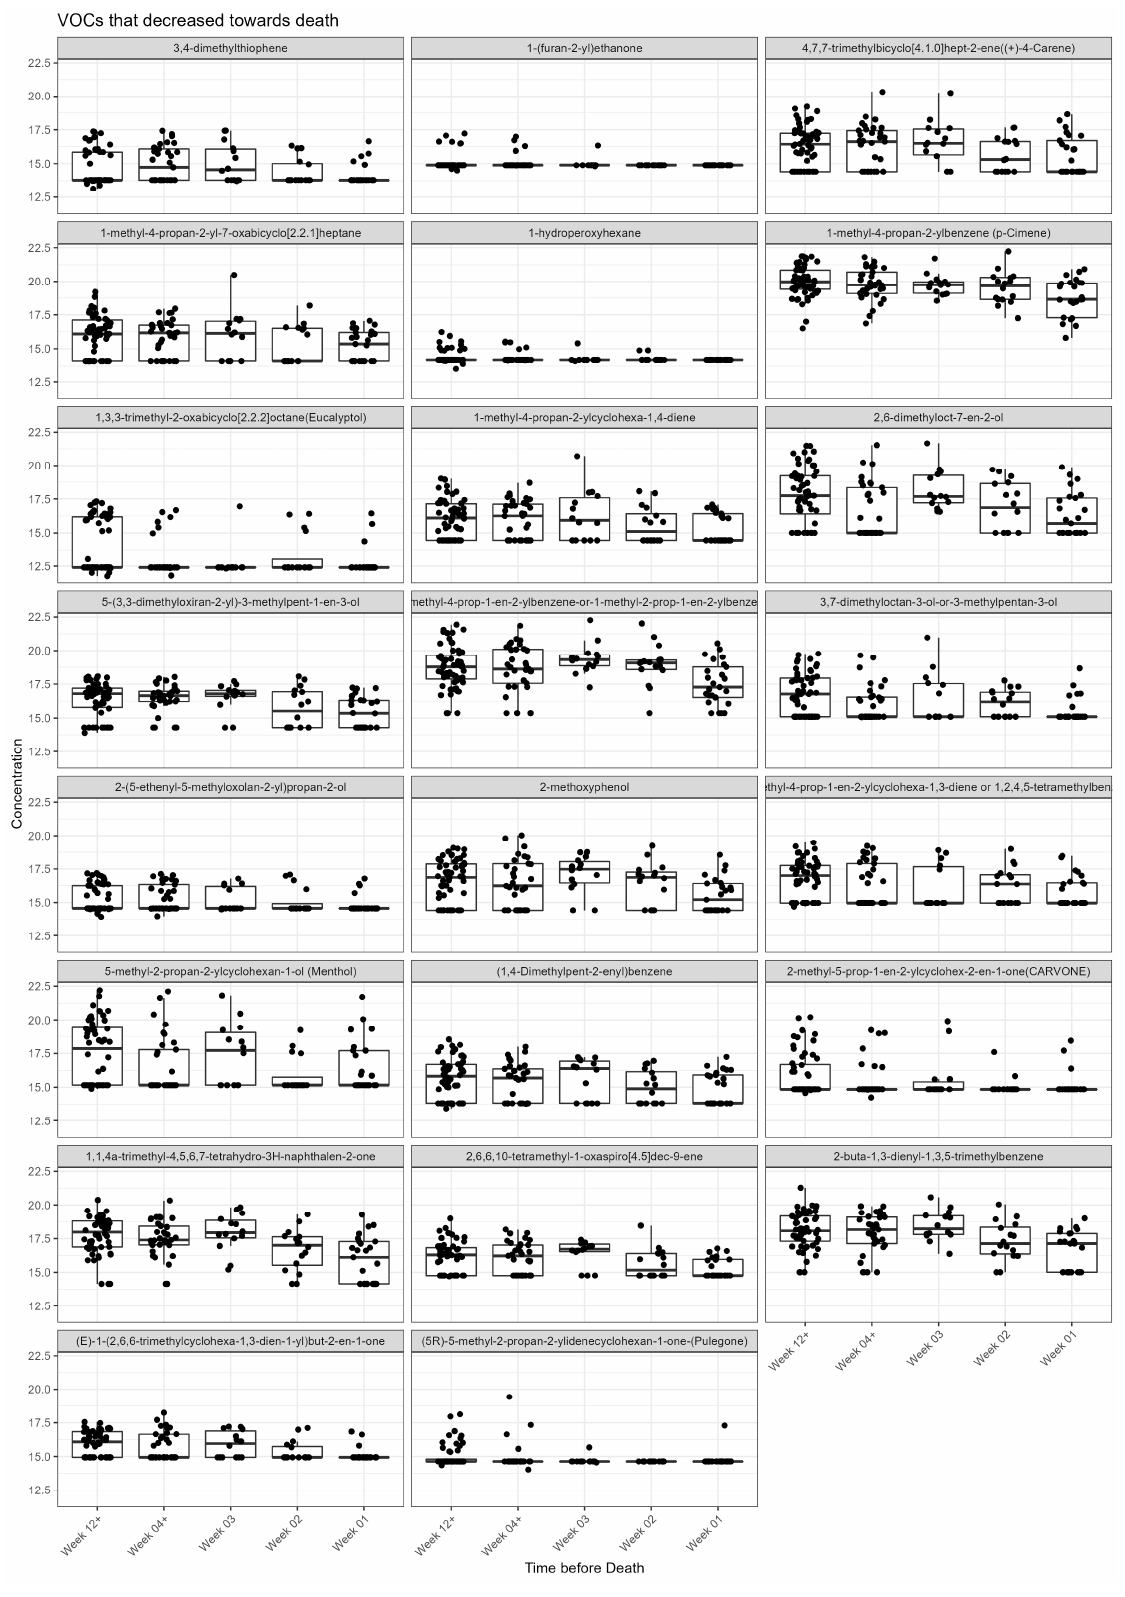
Figure 2. VOCs that decrease towards death in the acid dataset. Jitter box plot graph for each metabolite identified as significant from univariate and linear regression analysis. The centre line is the median; box limits are upper and lower quartiles; whiskers are 1.5 × interquartile range; points are individual observations. Y axis is VOC concentration on glog